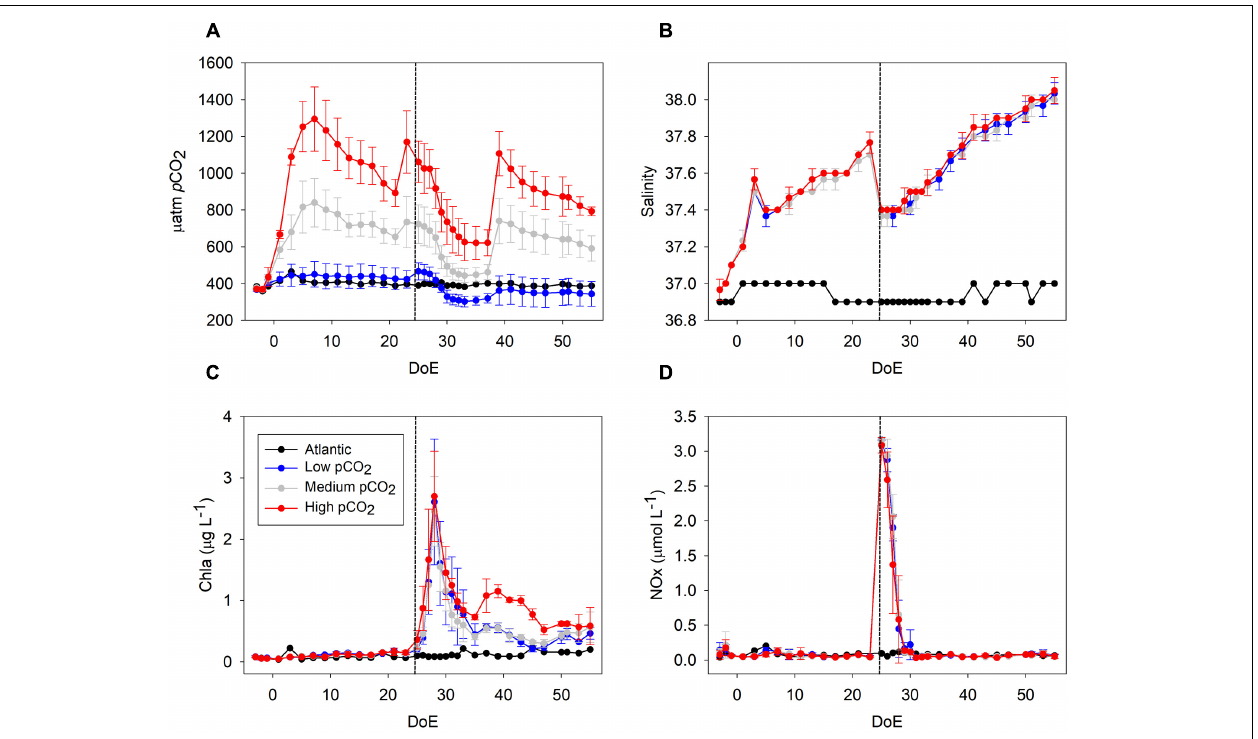
FIGURE 1 | Development of core parameters throughout the experiment. (A) p CO 2 ( µ atm), (B) salinity, (C) Chl a ( µ g L − 1 ), (D) NOx (nitrate + nitrite; µ mol L − 1 ). The addition of deep water (DW) in the mesocosms took place during the night between the 24th and 25th day of experiment (DoE); dashed line. Note that a clear draw down of CO 2 occurred during the phytoplankton bloom (t25–t35). Color code: black = Atlantic, blue = low- p CO 2 , gray = medium- p CO 2 , red = high- p CO 2 .